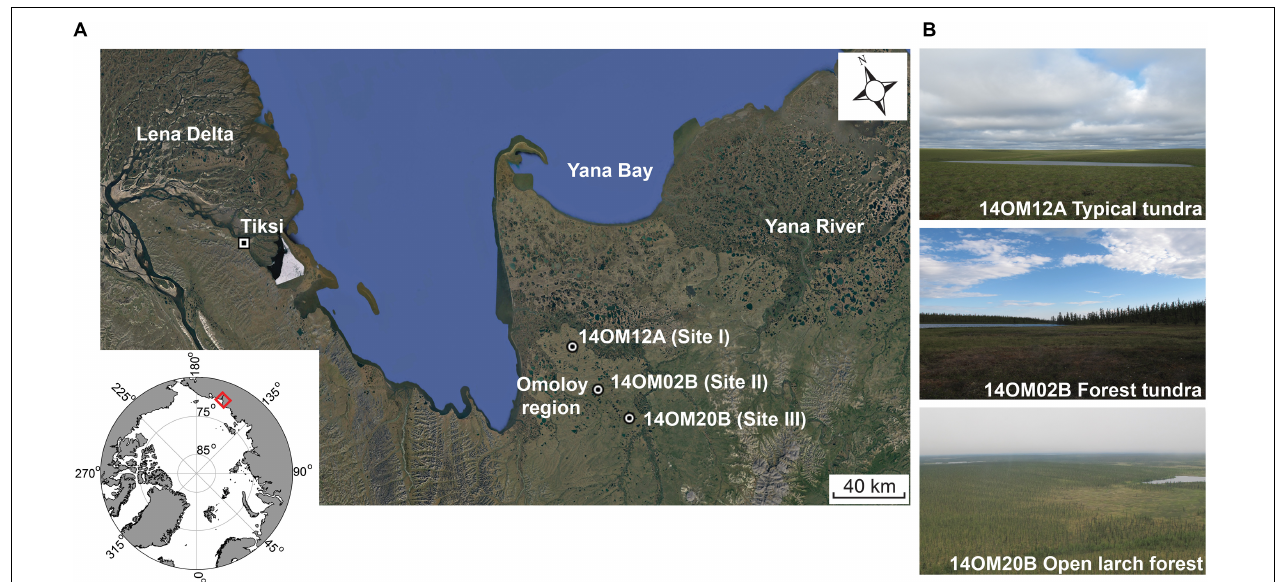
FIGURE 1 | The physical environment of the study area. (A) The location of the Omoloy region with the lake coring sites marked by dots (map created in Google Earth). (B) Photographs of representative vegetation surrounding the lakes along the modern north–south vegetation gradients (photos by Katharina Dulias, July